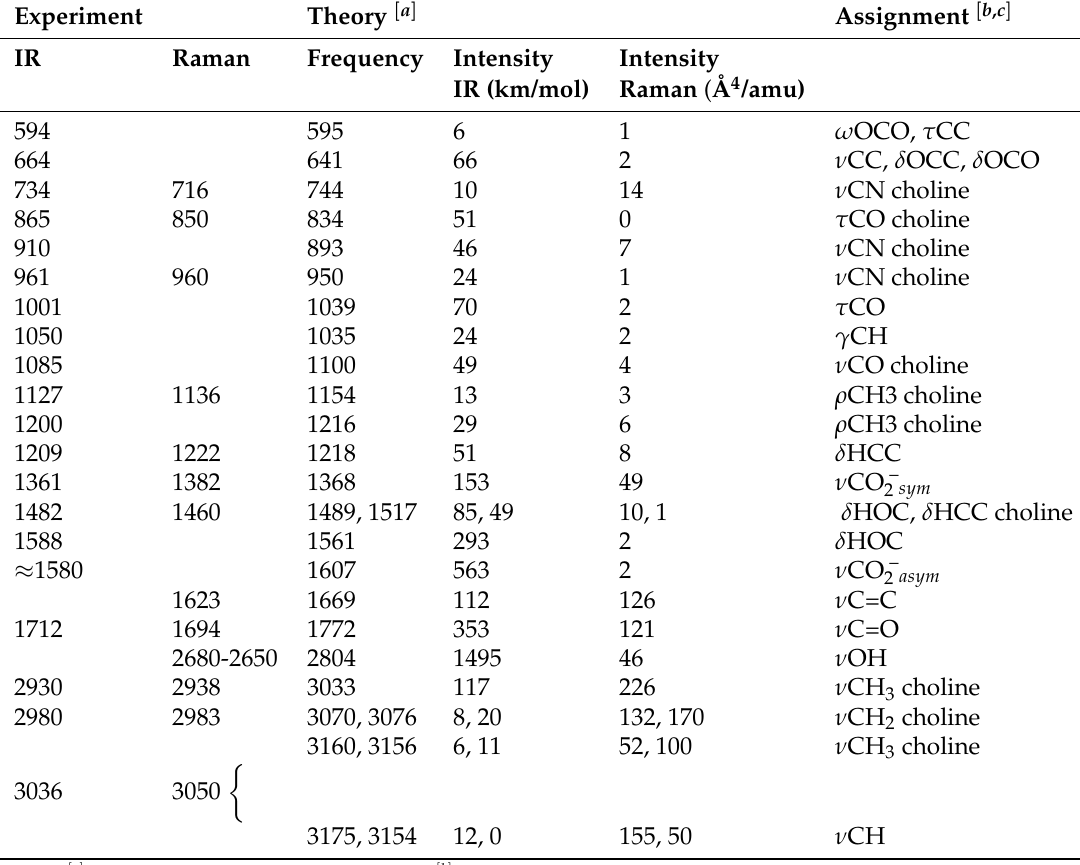
Table 2. Observed (IR and Raman) and calculated (B3LYP/6–311++G**) vibrational frequencies [cm − 1 ]